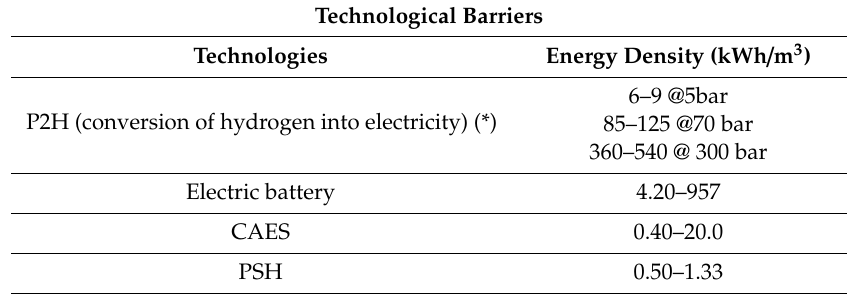
Table 4. Technological barriers. Energy density data from [104] except for P2H, which was preliminarily